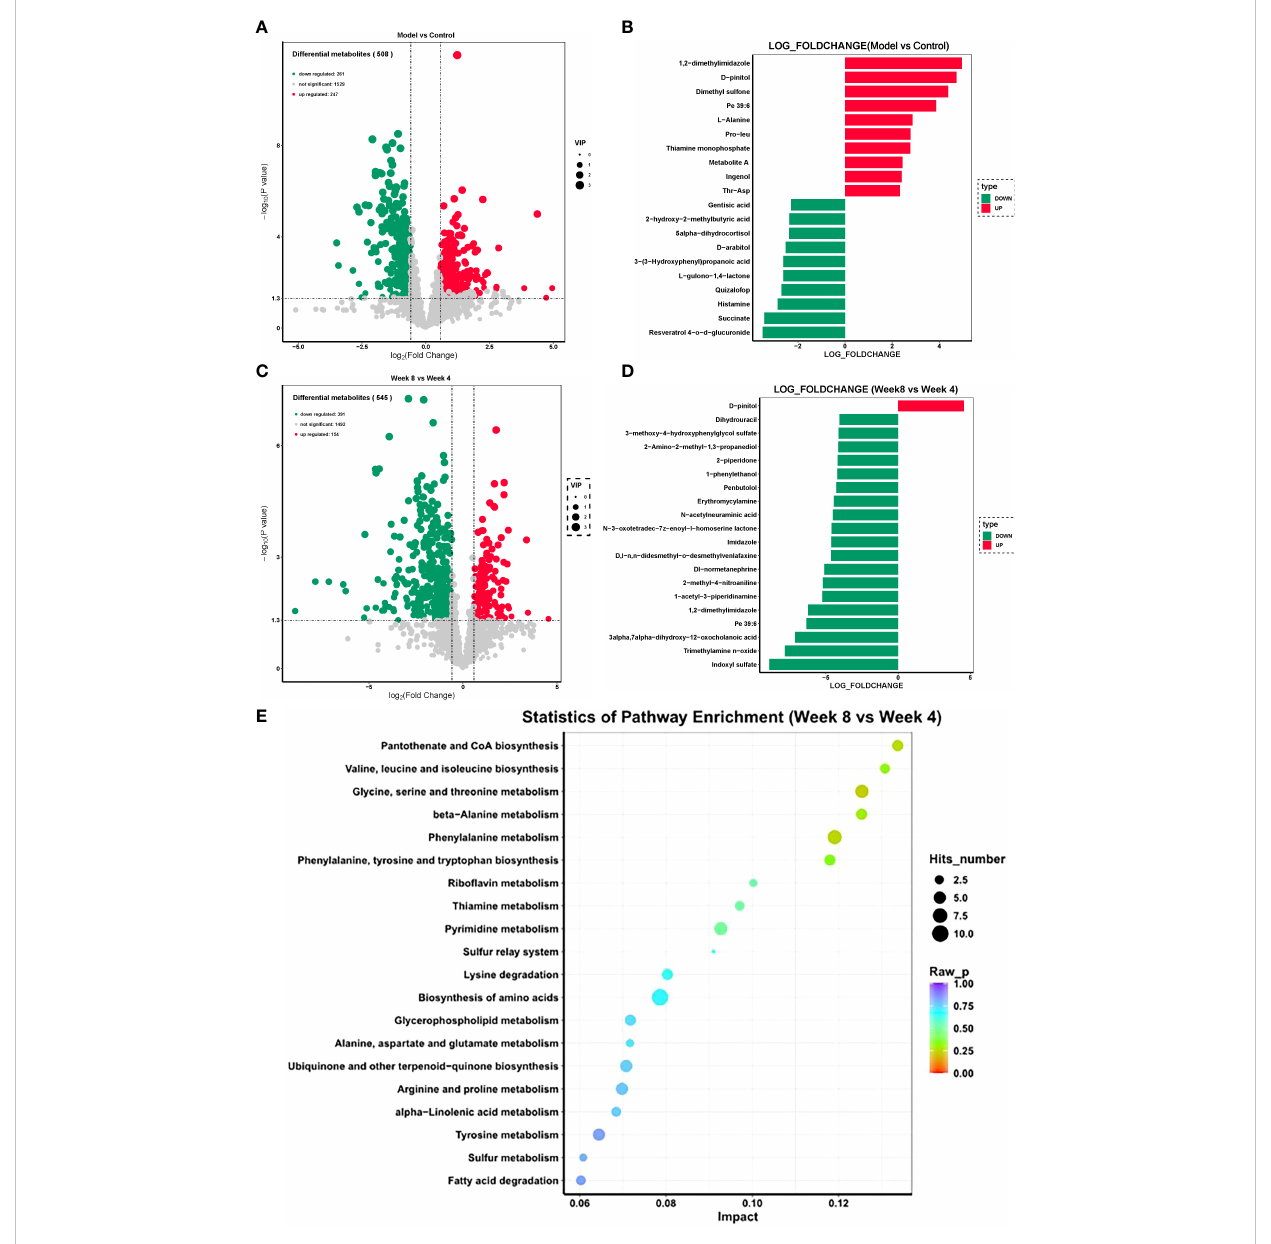
FIGURE 5 Fecal metabolism characteristics of CUMS rats. (A) Volcano plot of differential features between the CUMS group and the control group. (B) Top 10 differential metabolites between the CUMS group and the control group. (C) Volcano plot of differential features between the 8-week CUMS group and the 4-week CUMS group. (D) Top 10 differential metabolites between the 8-week CUMS group and the 4-week CUMS group. (E) KEGG pathways involved in the differential